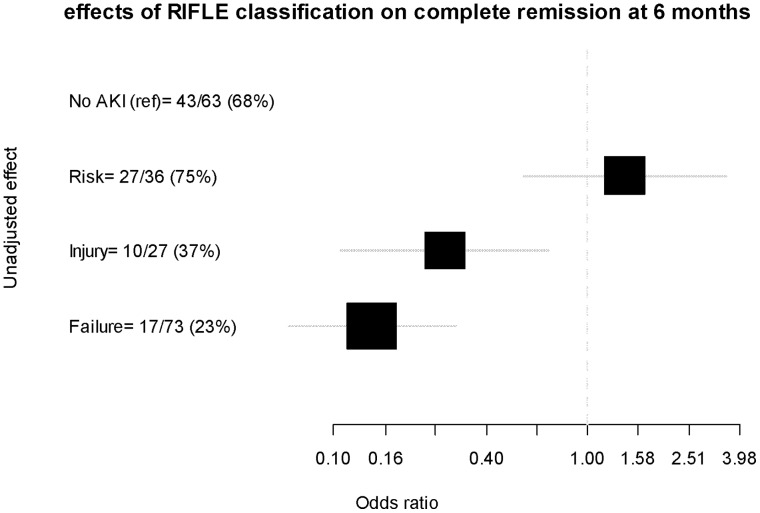
Effects of RIFLE classification on complete remission at 6 months.RIFLE classification scheme for acute kidney injury (AKI). The classification system includes separate criteria for creatinine and urine output (UO). A patient can fulfill the criteria through changes in serum creatinine (SCreat) or changes in UO, or both within 7 days. The criteria that lead to the worst possible classification should be used. R, RIFLE risk category: increased SCreat×1.5 or Glomerular filtration Rate (GFR) decrease >25% or UO <0.5 ml/kg/h×6 hours. I, RIFLE injury category: increased SCreat×2 or GFR decrease >50% or UO <0.5 ml/kg/h×12 hours. F, RIFLE failure category: increased SCreat×3 or SCreat greater than 4.0 mg/dl (350 µmol/l) with an acute increase of at least 0.5 mg/dl (44 µmol/l) or GFR decrease >75% or UO <0.3 ml/kg/h×24 hours or anuria×12 hours.